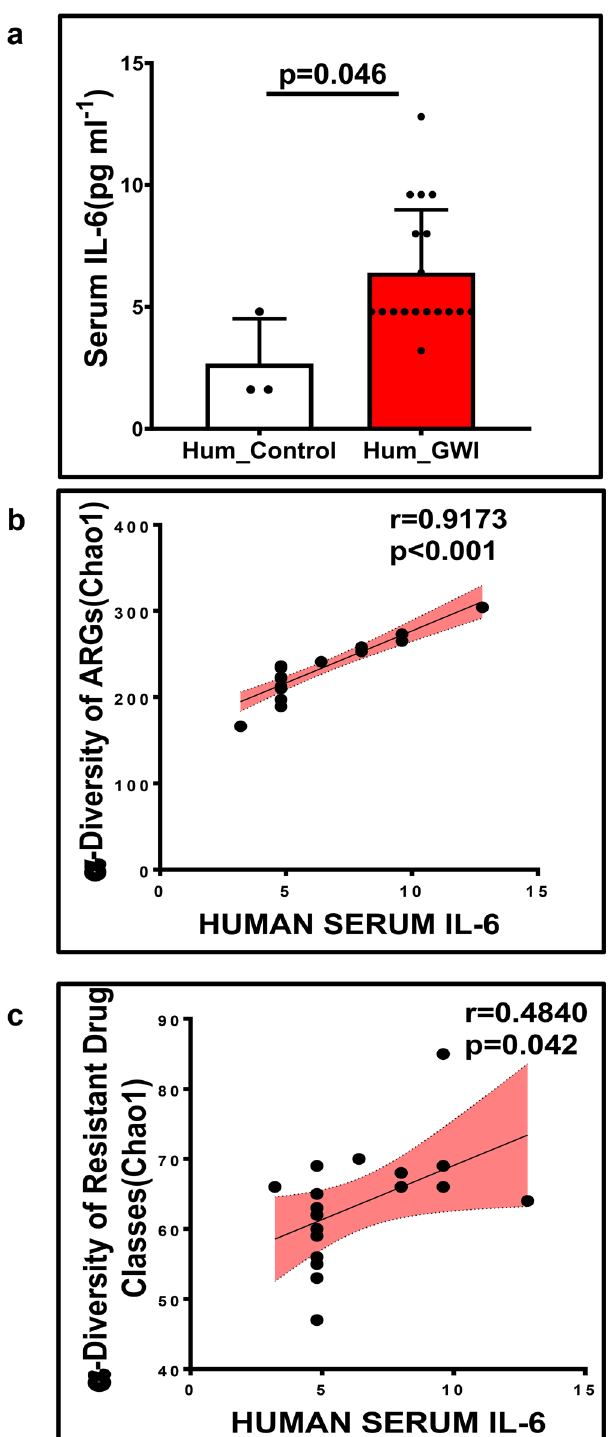
Fig. 7 Systemic IL-6 level and its correlation with antibiotic resistance genes and the resistant drug classes in GW Veteran samples. a Bar graph depicting the serum IL-6 level at pg/ml in Veteran control group Hum_Control ( n = 3 biologically independent samples) and Hum_GWI ( n = 18 biologically independent samples) groups. Correlation plot between α -diversity (Chao1) of b resistant ARGs and c resistant drug classes and serum IL-6 in Hum_GW group. Data are represented as mean ± SD (SD standard deviation). r -value was determined by Pearson ’ s regression analysis. Pearson ’ s linear regression is shown in red with 95% con fi dence bands. Statistical signi fi cance was analyzed by Welch ’ s two-tailed t -test where p < 0.05 was considered statistically signi fi